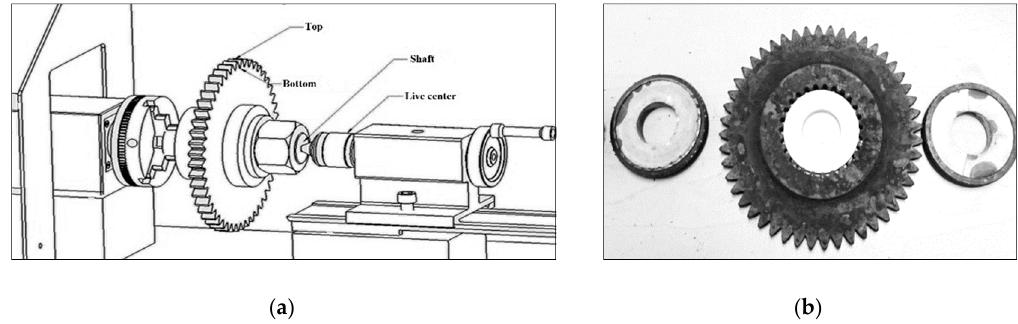
Figure 2. Gear assembly: ( a ) Overview of gear assembly and ( b ) ceramic rings assembly.